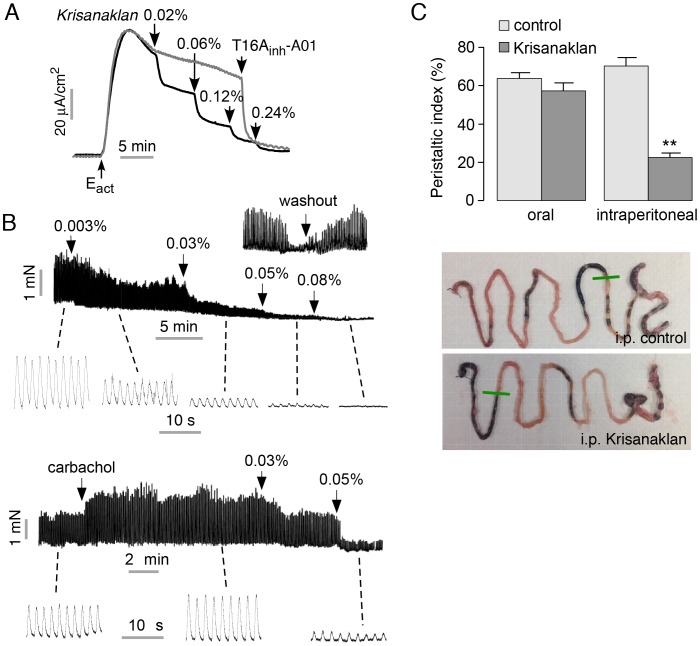
Krisanaklan inhibits TMEM16A Cl− current and intestinal contraction.A. Short-circuit current in TMEM16A-expressing FRT cells, showing Krisanaklan inhibition of 10 µM Eact (a TMEM16A activator)-stimulated TMEM16A Cl− current. Measurements were made following permeabilization of the basolateral membrane and in the presence of a transepithelial Cl− gradient (see Methods). Parallel study done with added Krisanaklan (grey curve); where indicated 5 µM T16Ainh-A01 (a TMEM16A inhibitor) was added. B. (top) Contractile force generated spontaneously by mouse ileal segment showing inhibition by Krisanaklan. (bottom) Krisanaklan inhibition of ileal contraction after stimulation by carbachol. Contraction data are representative of 3 sets of experiments. (inset) Reversibility of Krisanaklan action following washout. C. (top) Peristaltic index in mice receiving 3% Krisanaklan by intraperitoneal injection or oral gavage, compared to water control (mean ± S.E., 4 mice per group, ** P<0.01). (bottom) Representative photographs of small intestine, showing distance traveled of an activated charcoal meal.